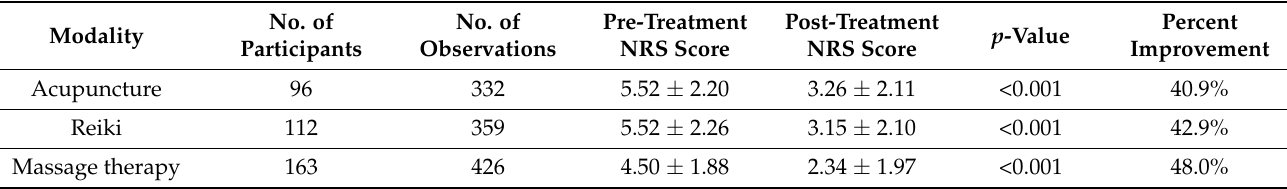
Table 4. Pre- and post-treatment NRS symptom scores for acupuncture, Reiki, or massage therapy for any reported symptom in the PIM arm.